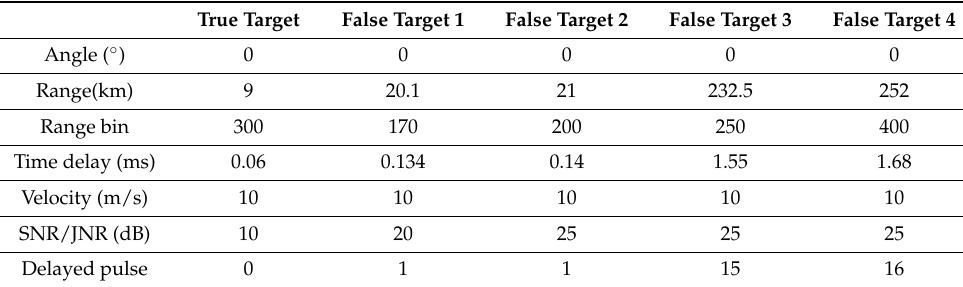
Table 2. Parameters of targets.